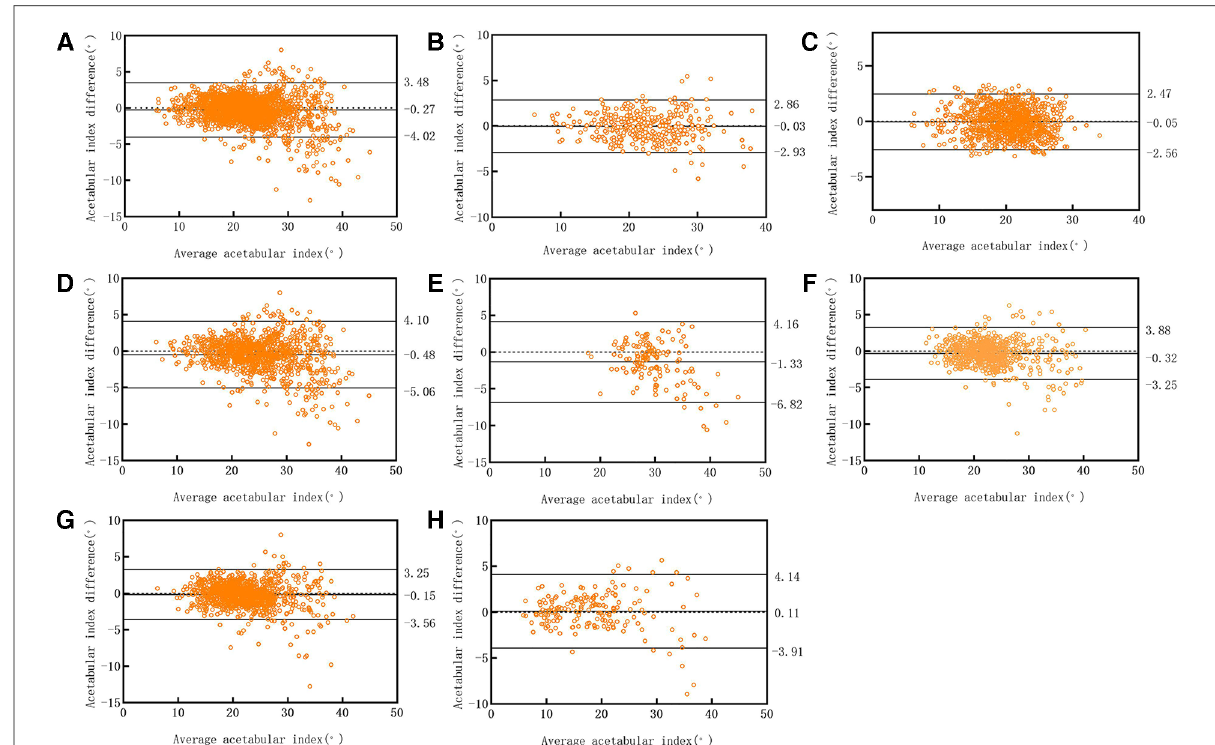
FIGURE 5 Bland – altman scatter plot: the diagnosis of deep learning system test set was compared to that of the clinician. ( A ) 1,000 cases in the test set; ( B ) 200 cases randomly selected from the test set; ( C ) normal group; ( D ) abnormal group; ( E ) infants <6 months of age; ( F ) infants ≥ 6 – 12 months of age; ( G ) infants ≥ 12 – 24 months of age; ( H ) children ≥ 24 months of